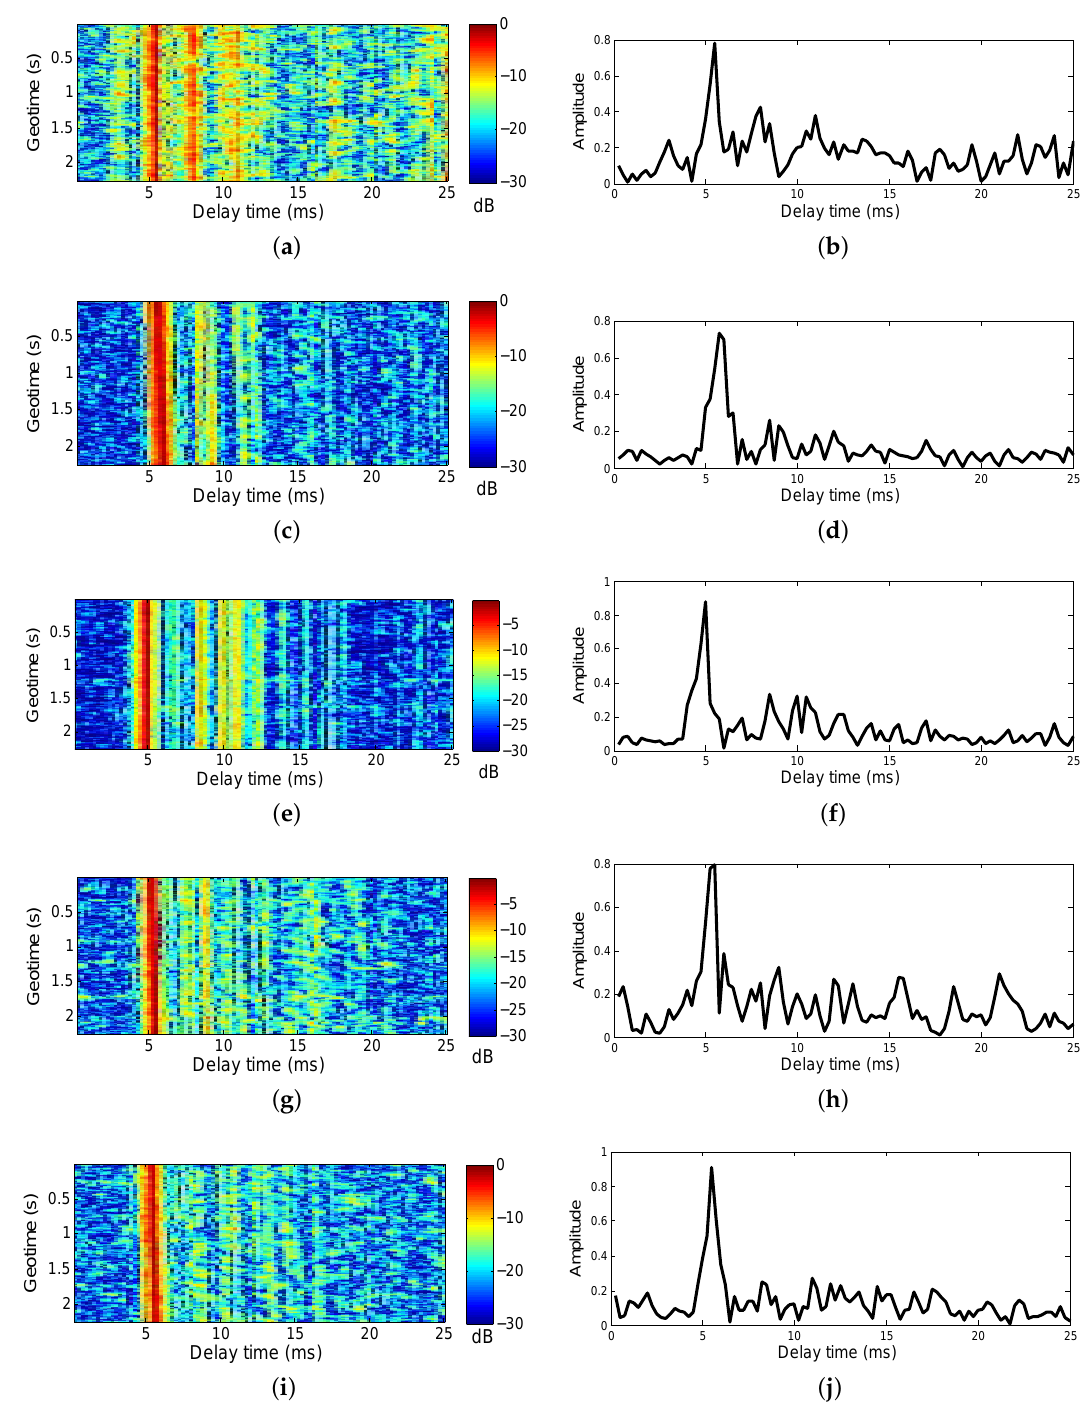
Figure 5. Examples of estimated CIRs for the DJK16 data at five transmissions. The left panel shows CIRs varies as a function of geotime, the right panel show a snapshot of the CIRs. ( a , b ) shows the CIRs from 5.2 km; ( c , d ) shows the CIRs from 4.98 km; ( e , f ) shows the CIRs from 5.09 km; ( g , h ) shows the CIRs from 5.18 km; and ( i , j ) shows the CIRs from 5.0 km,